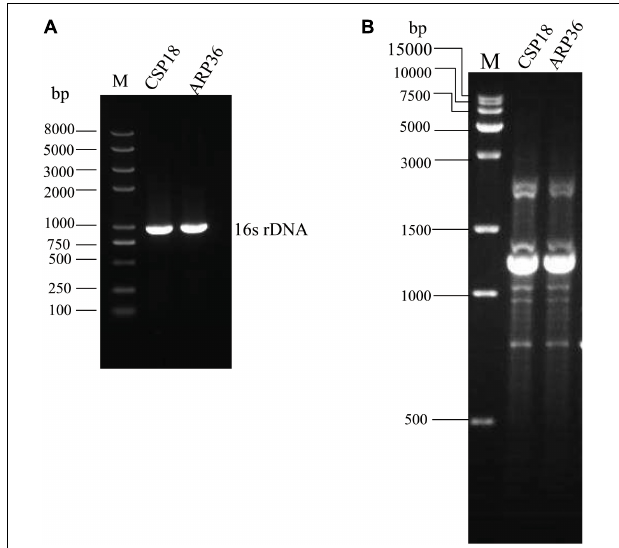
FIGURE 1 | PCR results of CSP18 and ARP36 strains. (A) 16S rDNA gene amplification. (B) RAPD